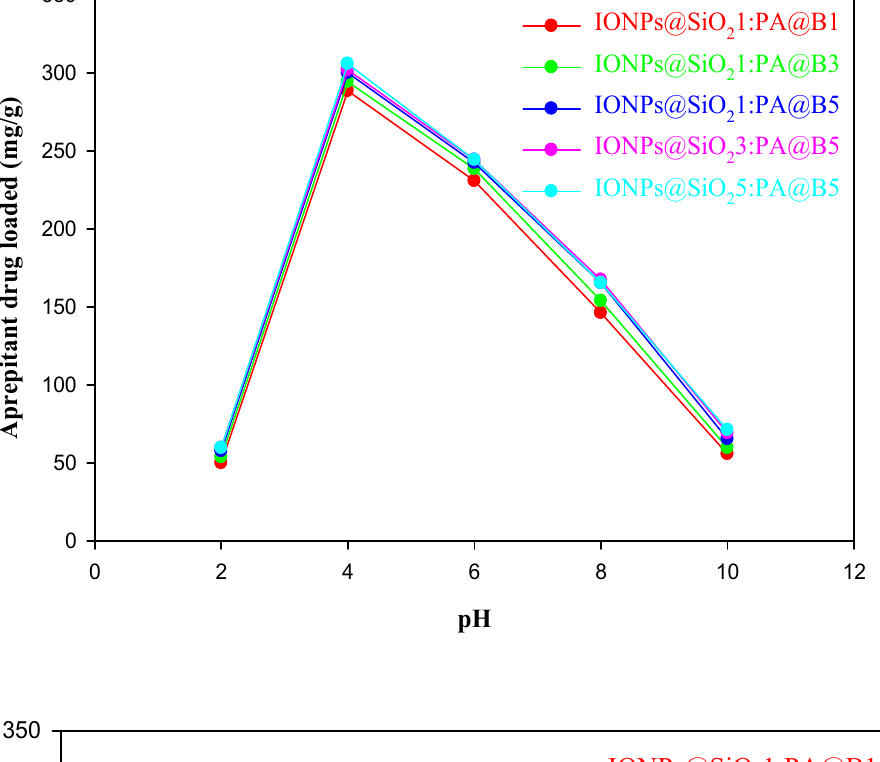
Figure 8. Loading of drugs into the fabricated MCM-PA@B at different time points:aprepitant ( A ); sofosbuvir ( B ).